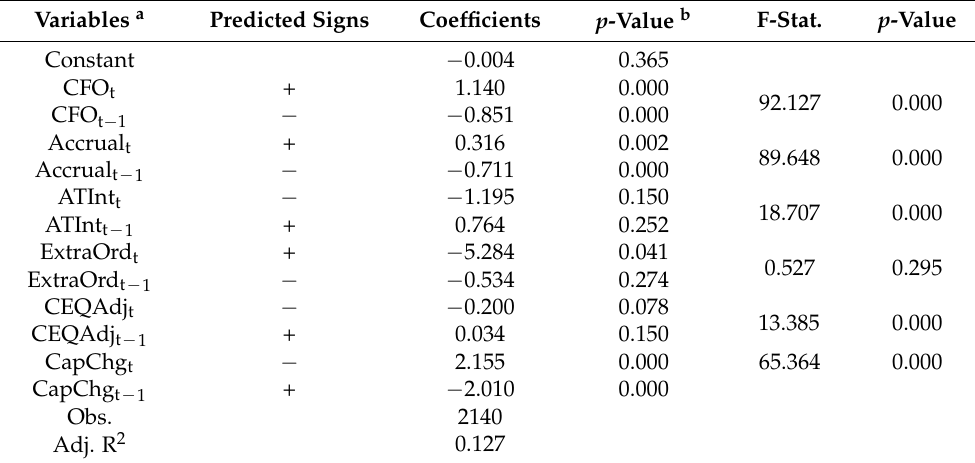
Table 3. Test for incremental information content of ERIC components among all firms: Cash flow from operation, accruals, after=tax interest expenses, certainty equivalent adjustments, and capital charge. Variables